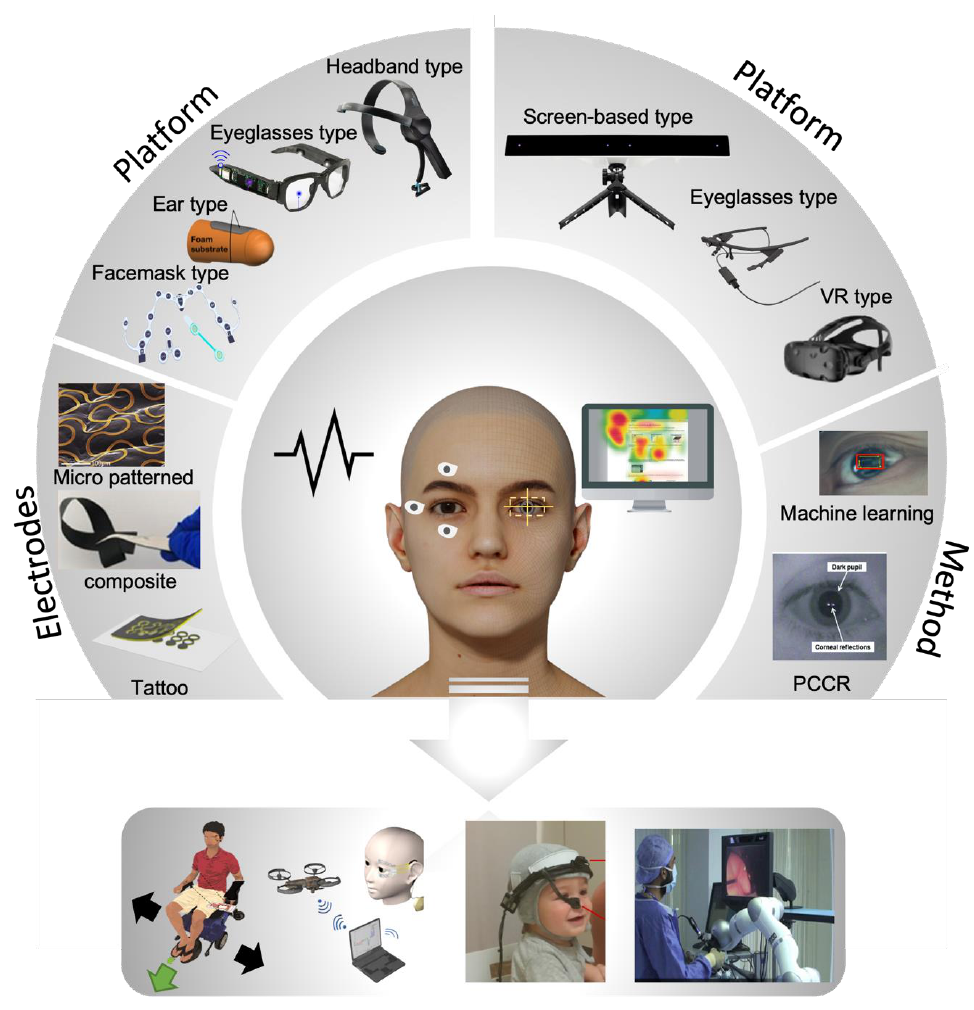
Figure 1. Recent advances in eye tracking sensors, systems, and methods (Screen-based type, Eye- glasses type (right), and VR type: Reprinted under terms of the CC-BY license [3]. Copyright 2020,